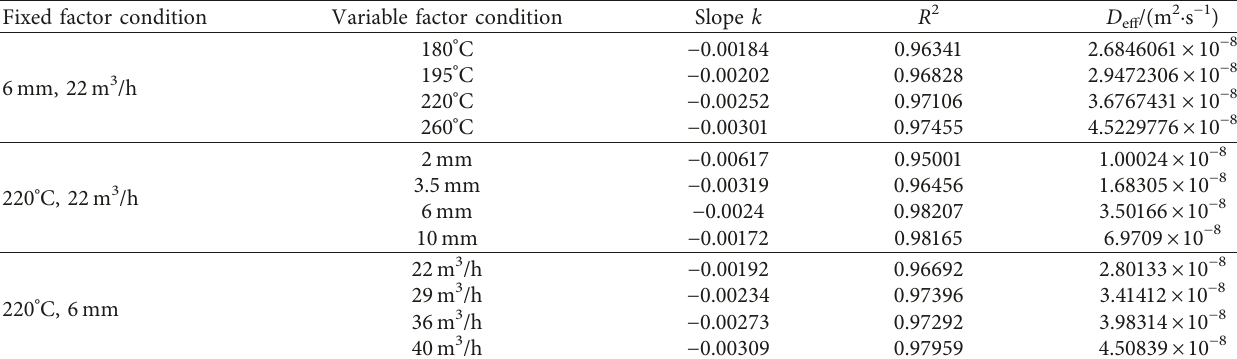
Table 9: Moisture effective diffusion coefficients of sludge under different superheated steam drying condition. Fixed factor